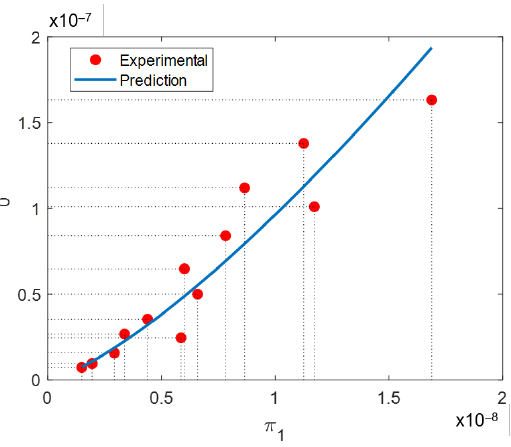
Table 11. Chemical composition, reported by the supplier [61], of Ti6Al4V powder used in [60]. Element